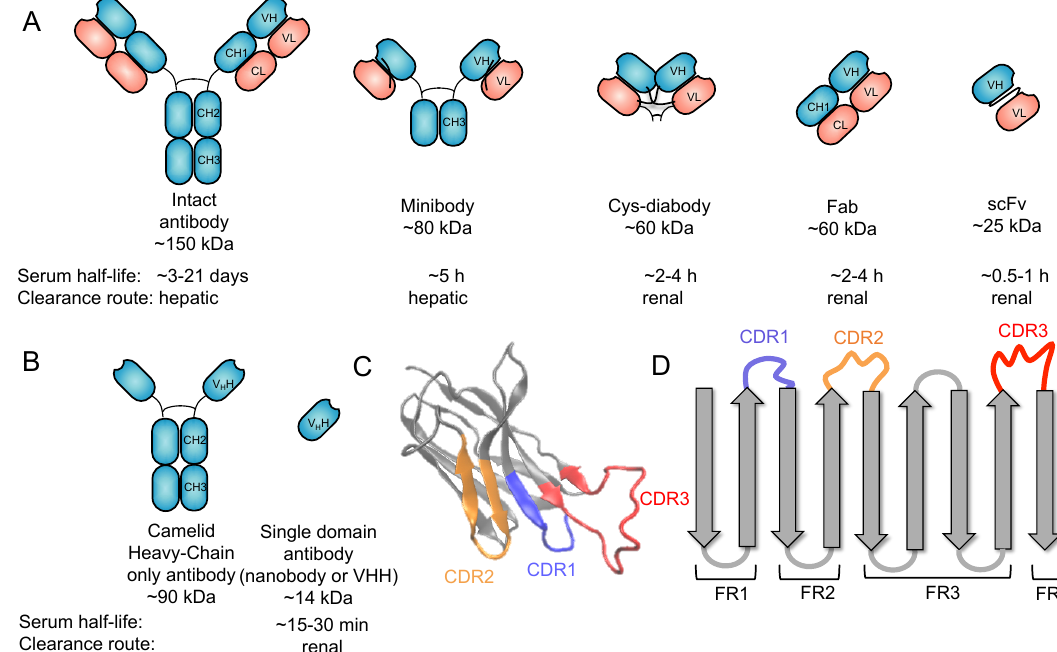
Figure 1. Human and camelid antibody fragments. ( A ) Structures of the human antibody fragments used for molecular imaging. Heavy chain is colored in blue and light chain in red. Antibody domains are labelled with their appropriate names (CH—constant heavy; VH—variable heavy; VL—variable light; VHH—variable heavy of heavy-chain-only antibodies). Size and circulation half-lives are mentioned below the structures. ( B ) Camelid heavy chain-only antibody and VHH antibody fragment. ( C ) Crystal structure of the nanobody (PDB ID: 6OS1) with residues of CDRs colored. ( D ) Schematic representation of the VHH domain framework and CDR regions. Arrows represent beta